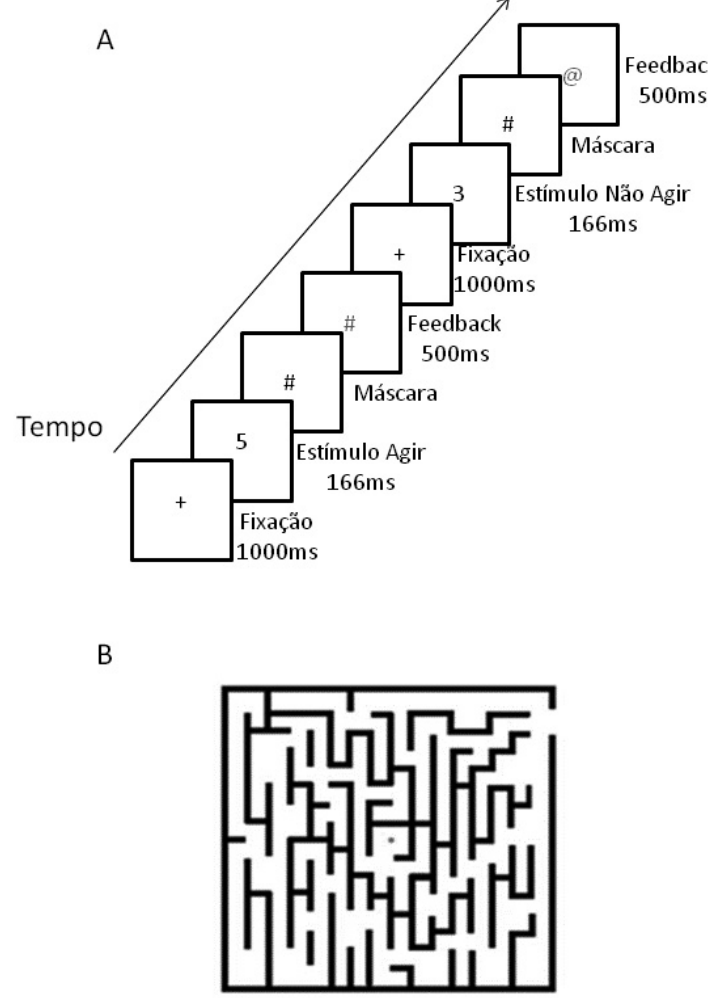
Figura 1 . (A) Sequência esquemática de eventos em duas provas da tarefa Agir/Não Agir. (B) Exemplo de